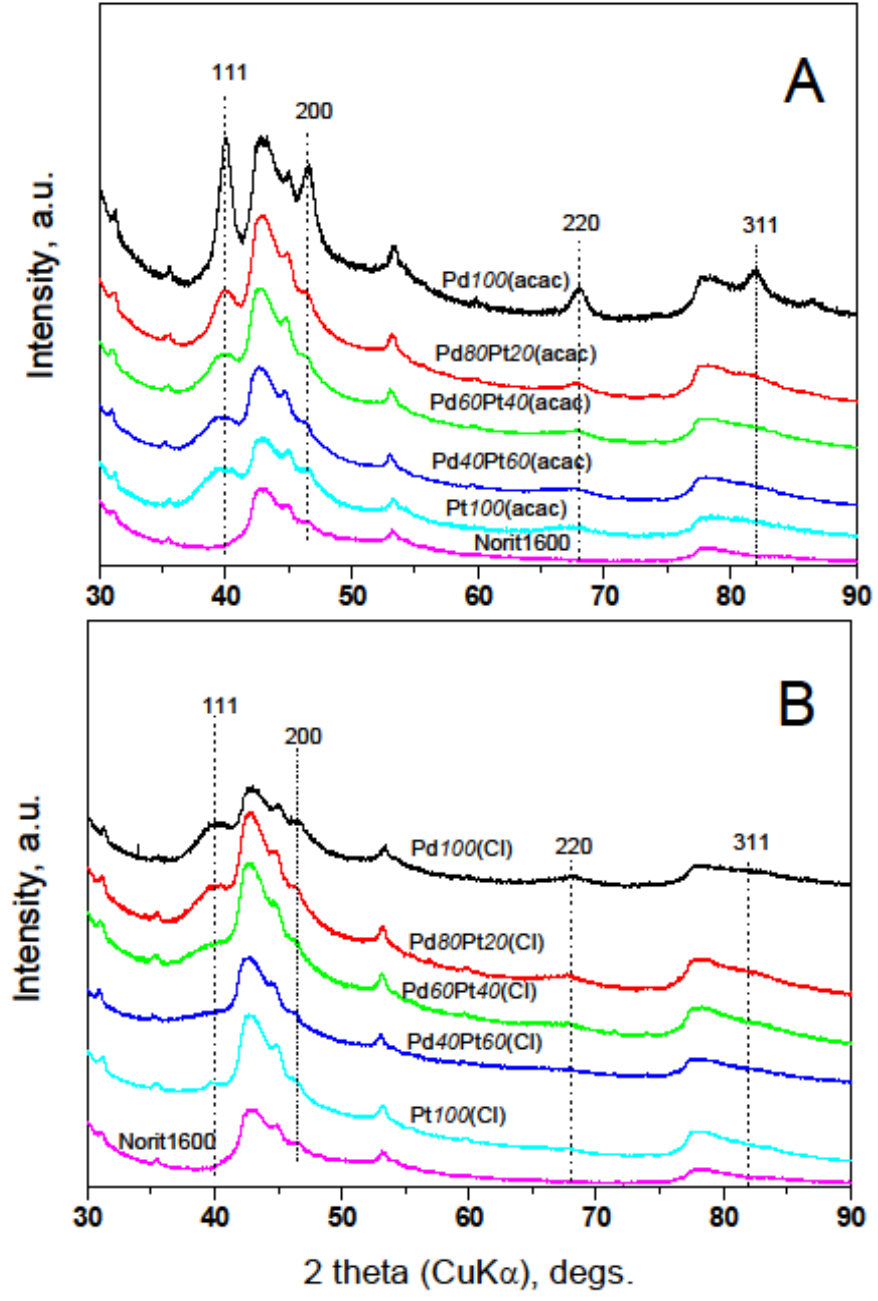
Figure 3. XRD spectra of prereduced Pd–Pt / C catalysts. ( A ) ex-metal acetylacetonates, ( B ) ex-metal chlorides. Only the area with the most important XRD reflections from the metallic fcc phase (Pd / Pt) is shown.